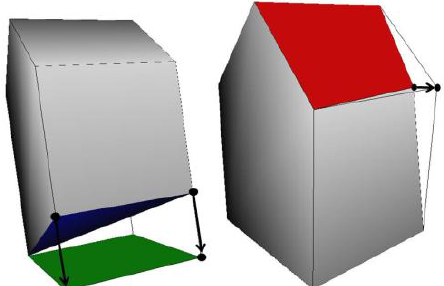
Figure 7. Healing of the Ground and